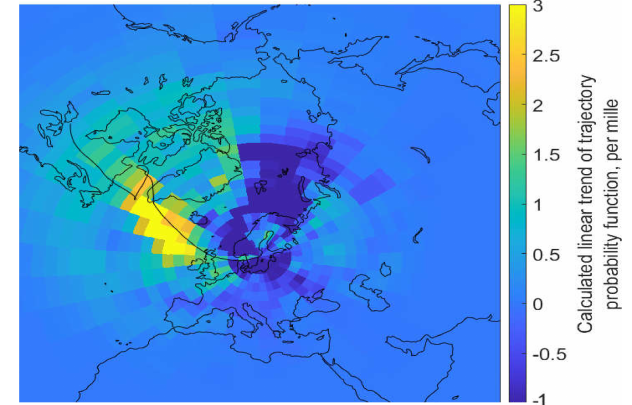
Figure 15. Trend in probability of transport across different source regions expressed as a linear fit of the trajectory probability function over the 18-year period. Units expressed as per